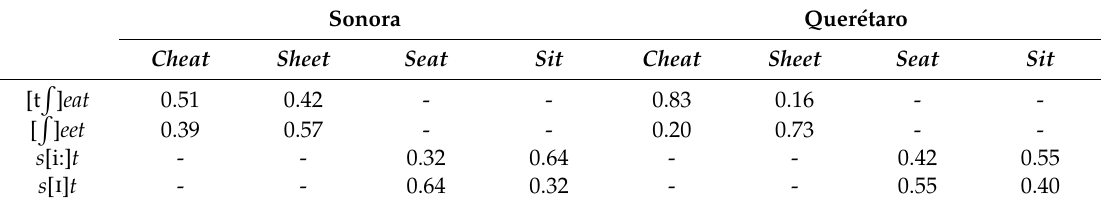
Table 1. Proportion of times each auditorily presented lexical item was identified as being an instance of one of four possible words ( cheat , sheet , seat , sit ), further broken down by region of origin, in Mexico, of the English learners (Sonora, Quer é